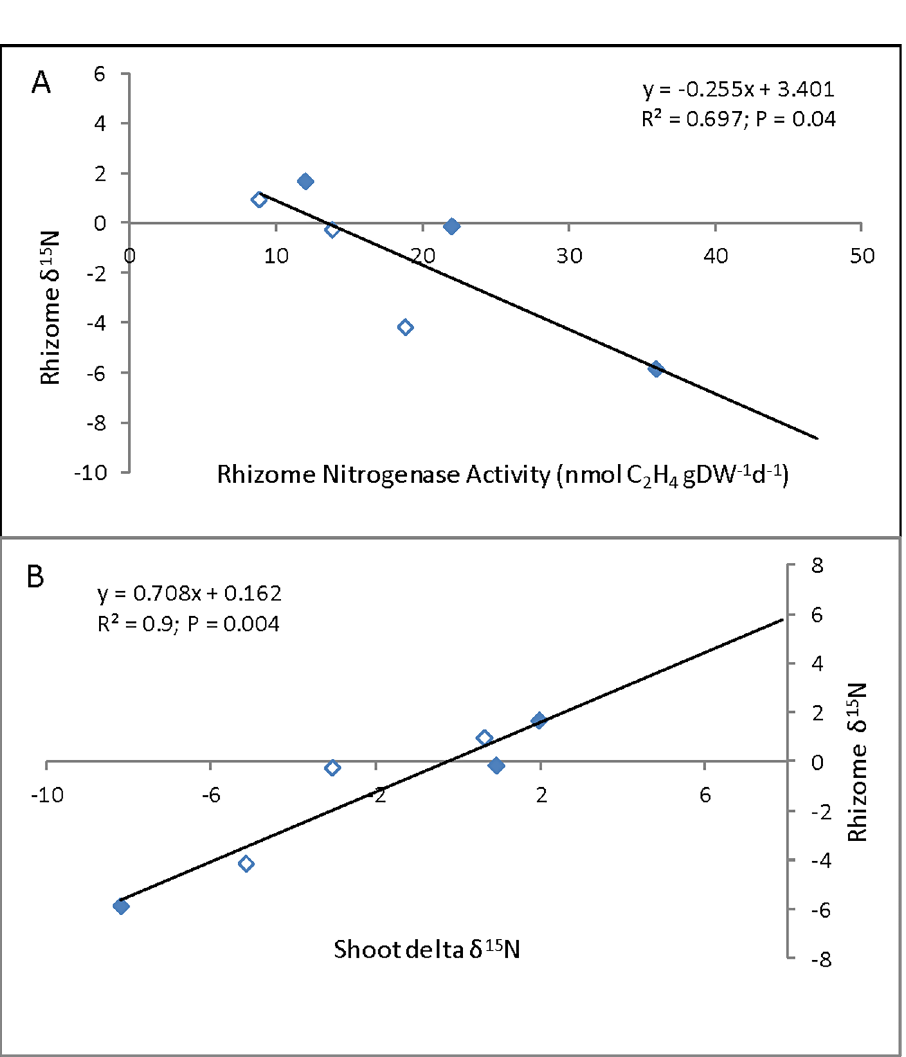
Fig 2. Relationship between rhizome nitrogenase activity and rhizome δ 15 N (A) and shoot and rhizome δ 15 N (B) in Schoenoplectus californicus from Lake Atitla´n; full diamond–unpolluted sites, empty diamonds–polluted sites. Each nitrogenase activity value is a mean of 3–4 replicates, isotope data were measured on pooled samples. Nitrogenase activity expressed as ethylene production (nmol C 2 H 4 gDW -1 d -1